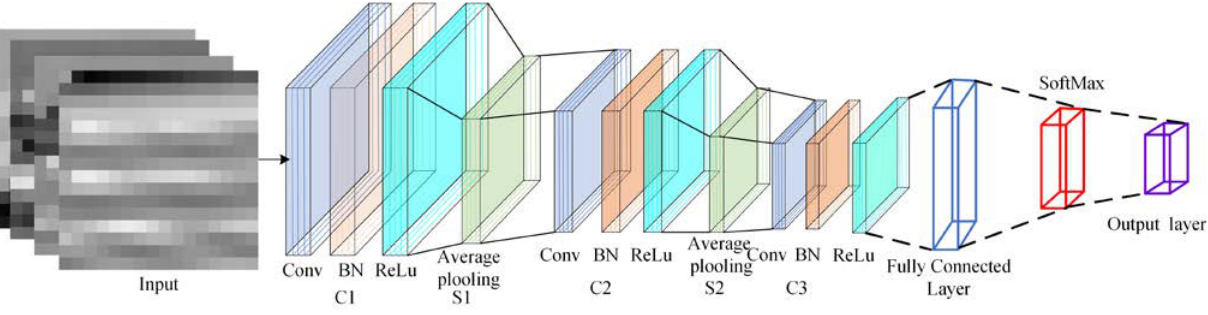
Figure 10. Improved CNN model diagram.